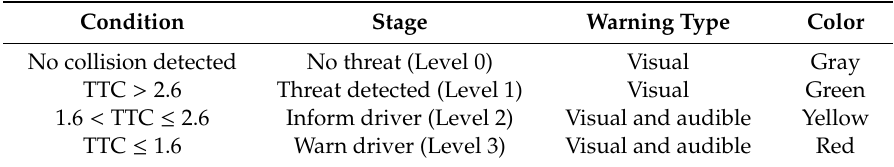
Table 8. Conditions for the vehicle collision warning stages.